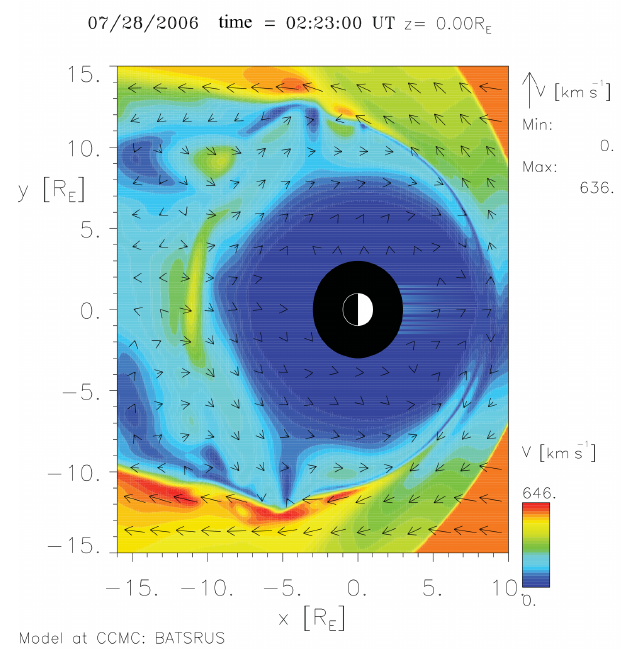
Figure 9. X – Y cut at 02:23UTC showing velocity vectors super- posed on the velocity magnitude. It is observed that on the dawn- flank region nearby the observed vortices, the magnetosheath veloc- ity magnitude is higher than that observed in the solar wind outside the bow shock, higher than 600kms − 1 . This diagram was made us- ing the visualization tool available online through the CCMC web-